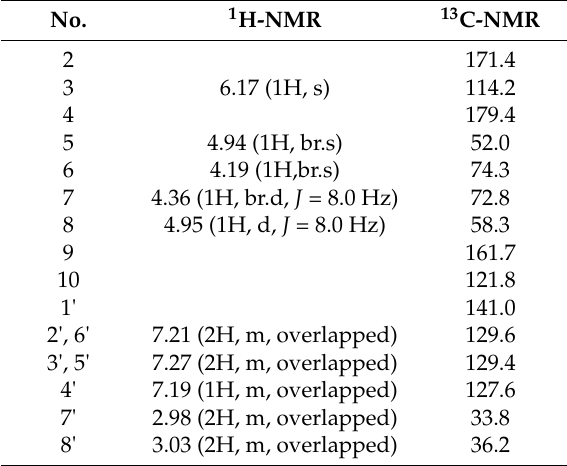
Table 1. 1 H-NMR and 13 C-NMR spectroscopic data of Compound 1 ( J in Hz) a .